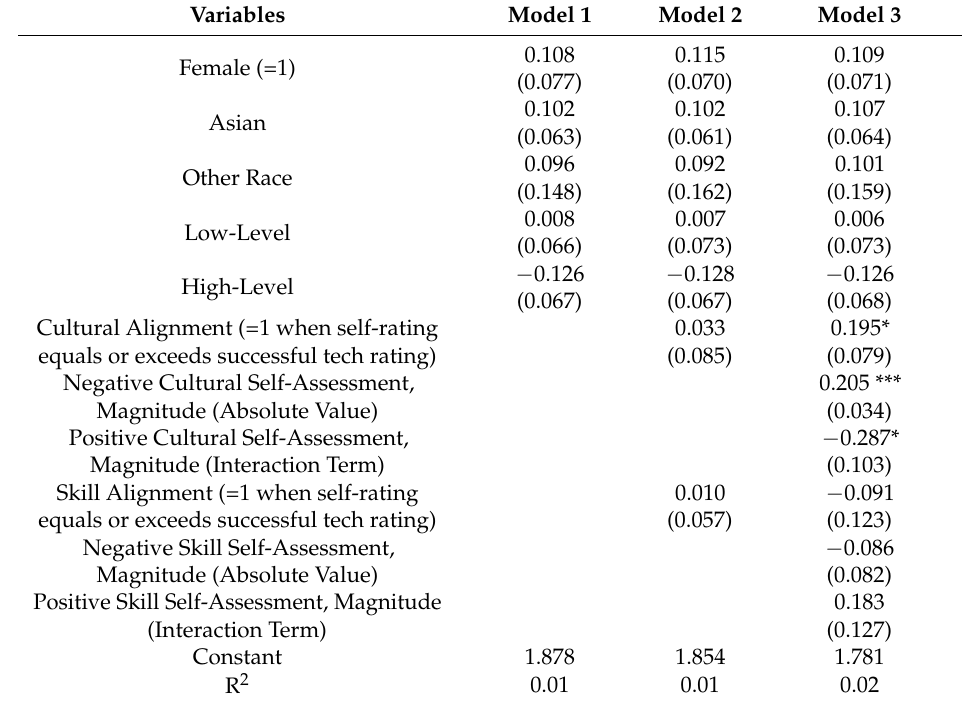
Table 4. OLS Regression Estimates for the Effects of Cultural and Skill Alignment on Silicon Valley Tech Workers’ Plans to Switch Career